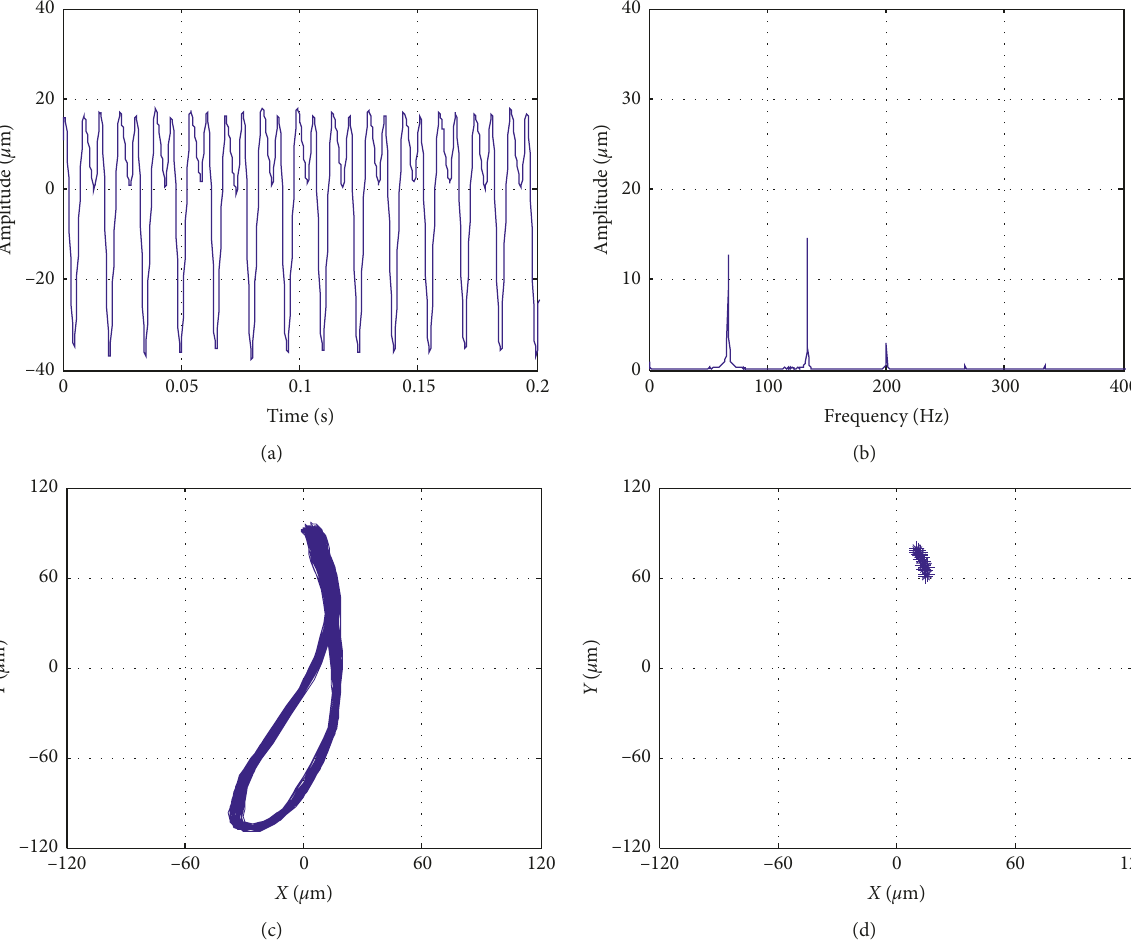
Figure 15: Severe rubbing at 4000r/min. (a) Time-domain waveform. (b) Spectrum graph. (c) Axis orbit. (d) Poincare